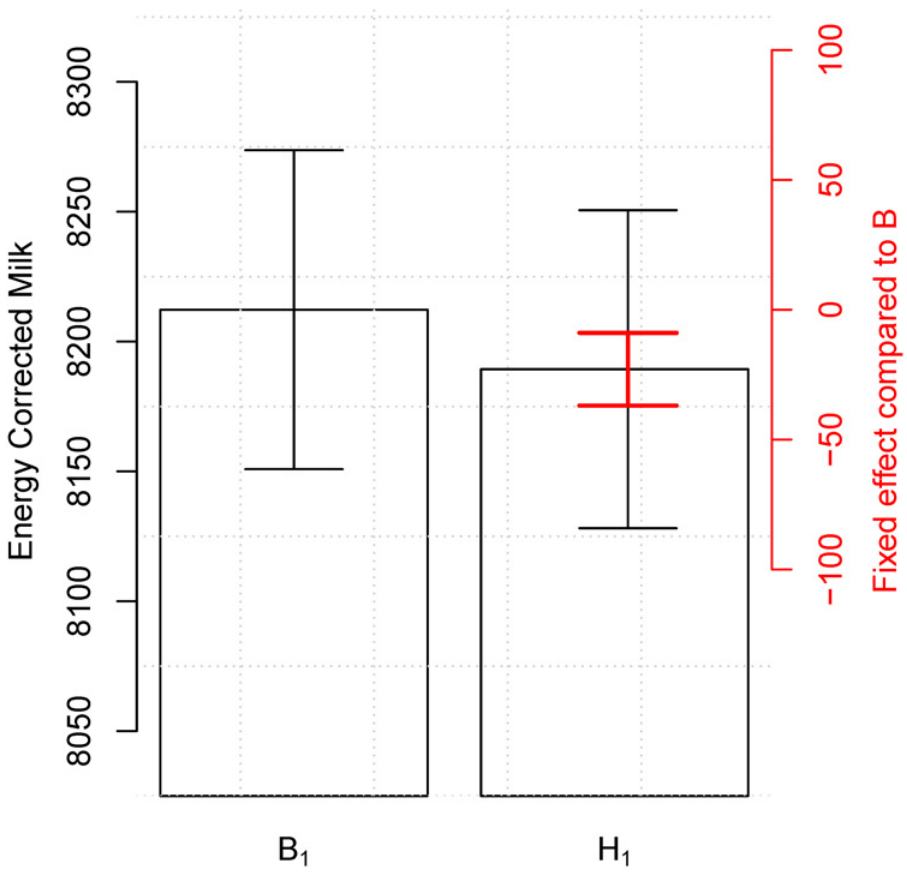
Fig 2. Influence of calf sex on milk production in the first lactation period. When using the best model (Eq 2) including yearly, seasonal, calving, and herd effects there is a significant difference of 22.92 kg ECM ( sd = 7.145) between having a bull or a heifer calf as the first calf (red CI). When including the variance of the reference level the difference is masked (black CI). The numerical results are available in Table 4.